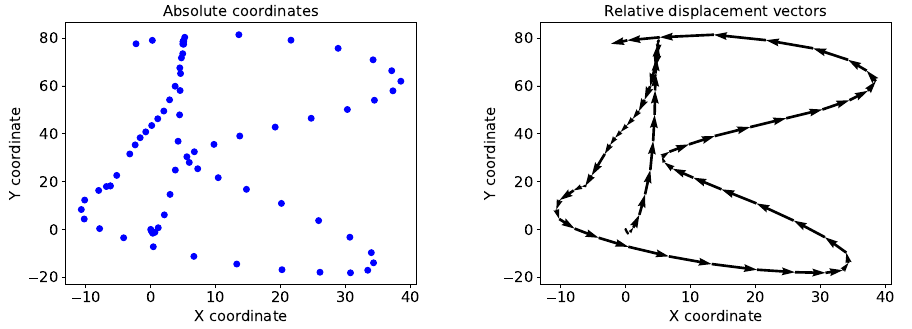
Figure 5. Absolute coordinates of the character ‘B’ ( left ), and the calculated relative displacement vectors of the same character ( right